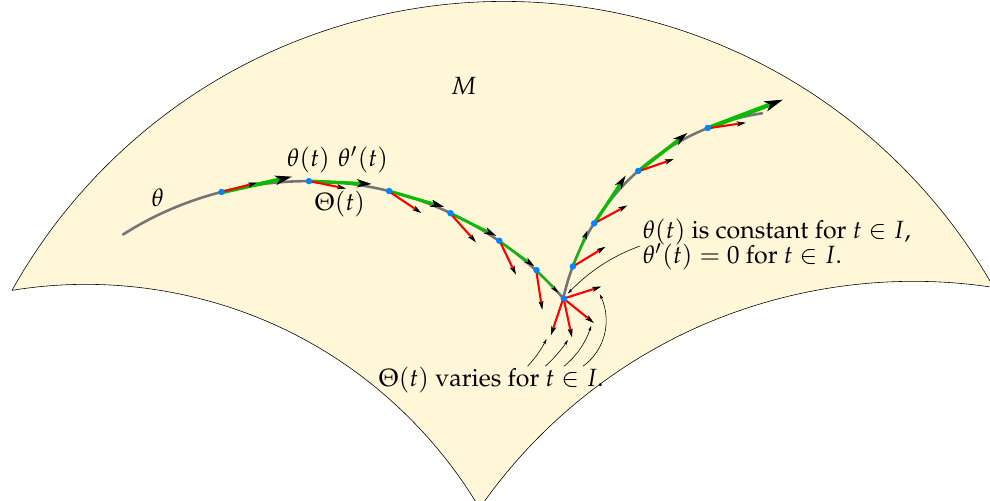
Figure 1. A picture of the manifold M , path θ , and vector fields θ (cid:48) and Θ . The blue dots represent θ ( t ) at certain points t ∈ R , while the green and red arrows represent θ (cid:48) ( t ) and Θ ( t ) at at these points respectively. Note that Θ is a unit-length vector field along θ and varies within I , whereas θ (cid:48) is a vector field along θ that vanishes within I